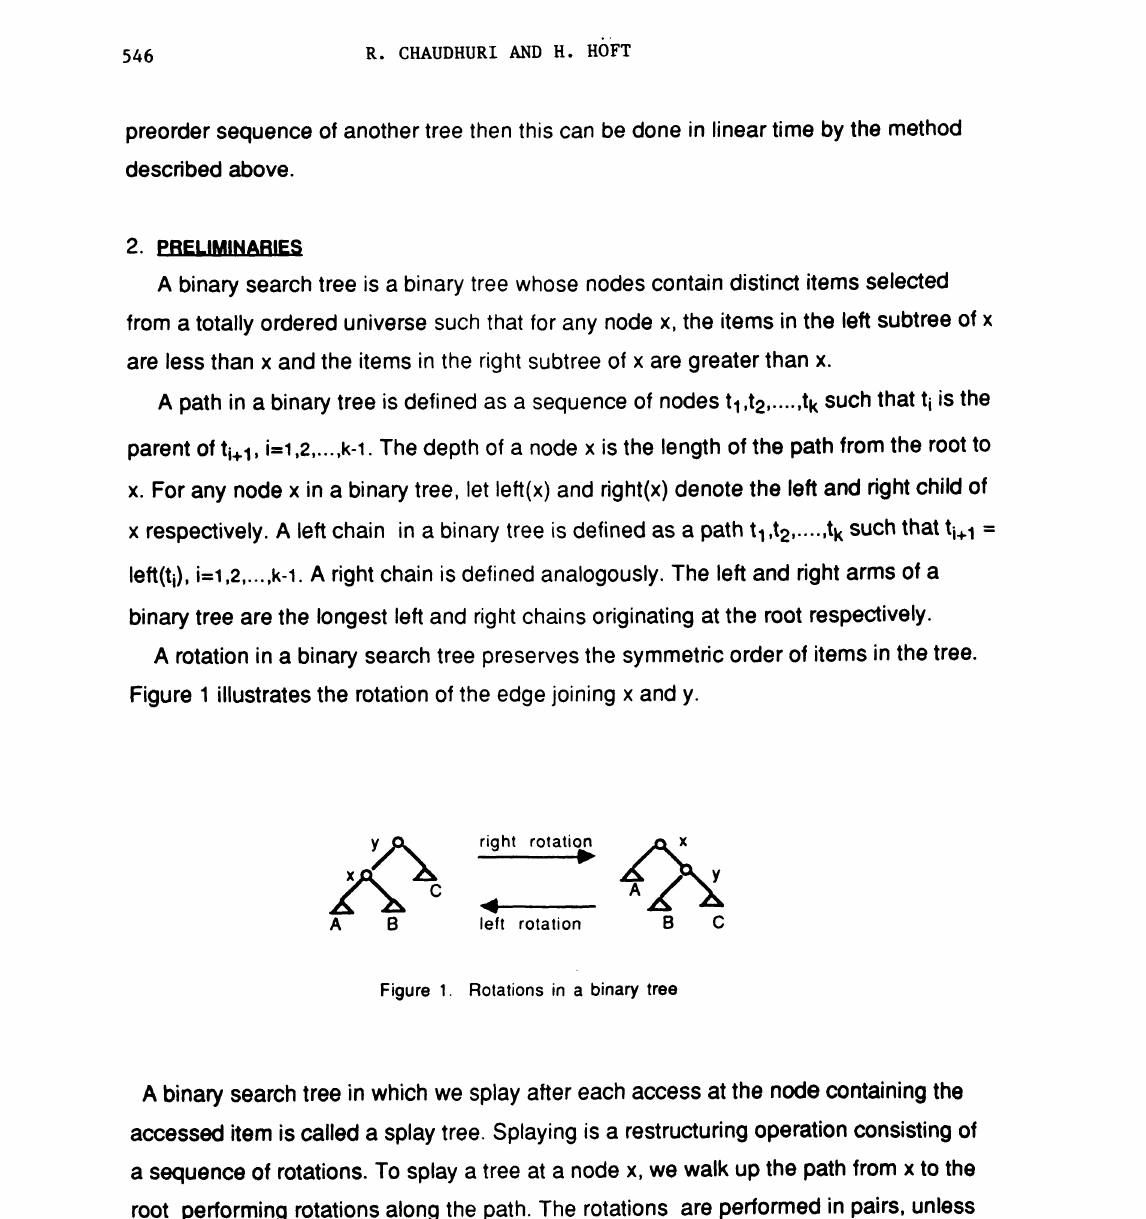
Figure 1. Rotations in a binary